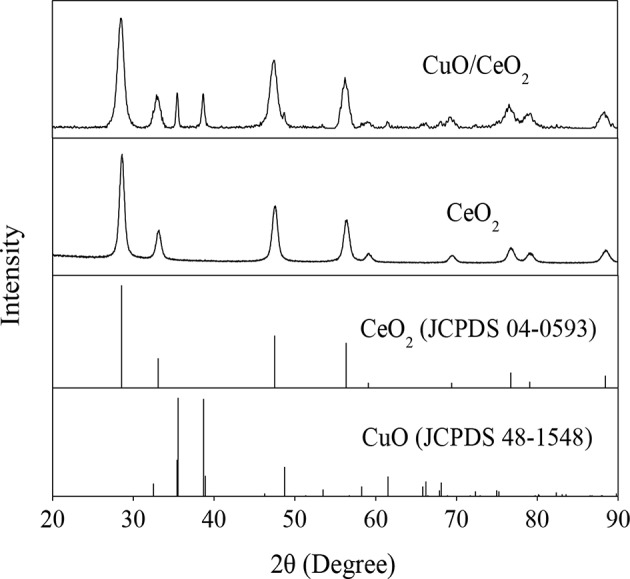
XRD pattern of CuO/CeO2.